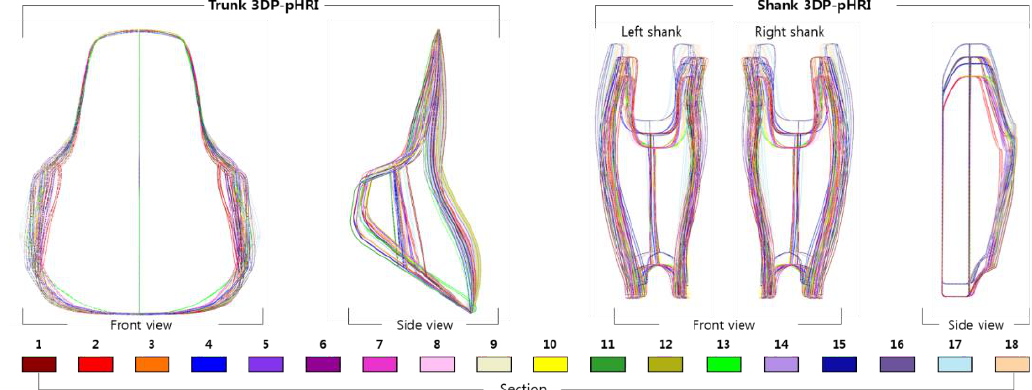
Figure 8. Procedure of development of 3DP-pHRI based on size system.